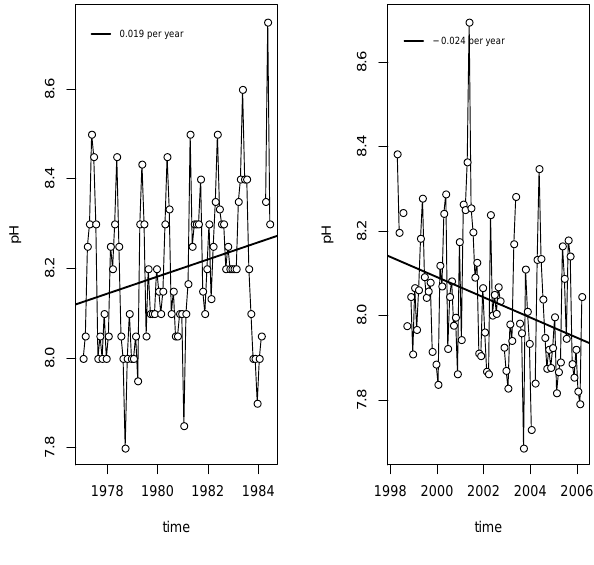
Fig. 5. Within-section linear regressions on raw data from North Sea station